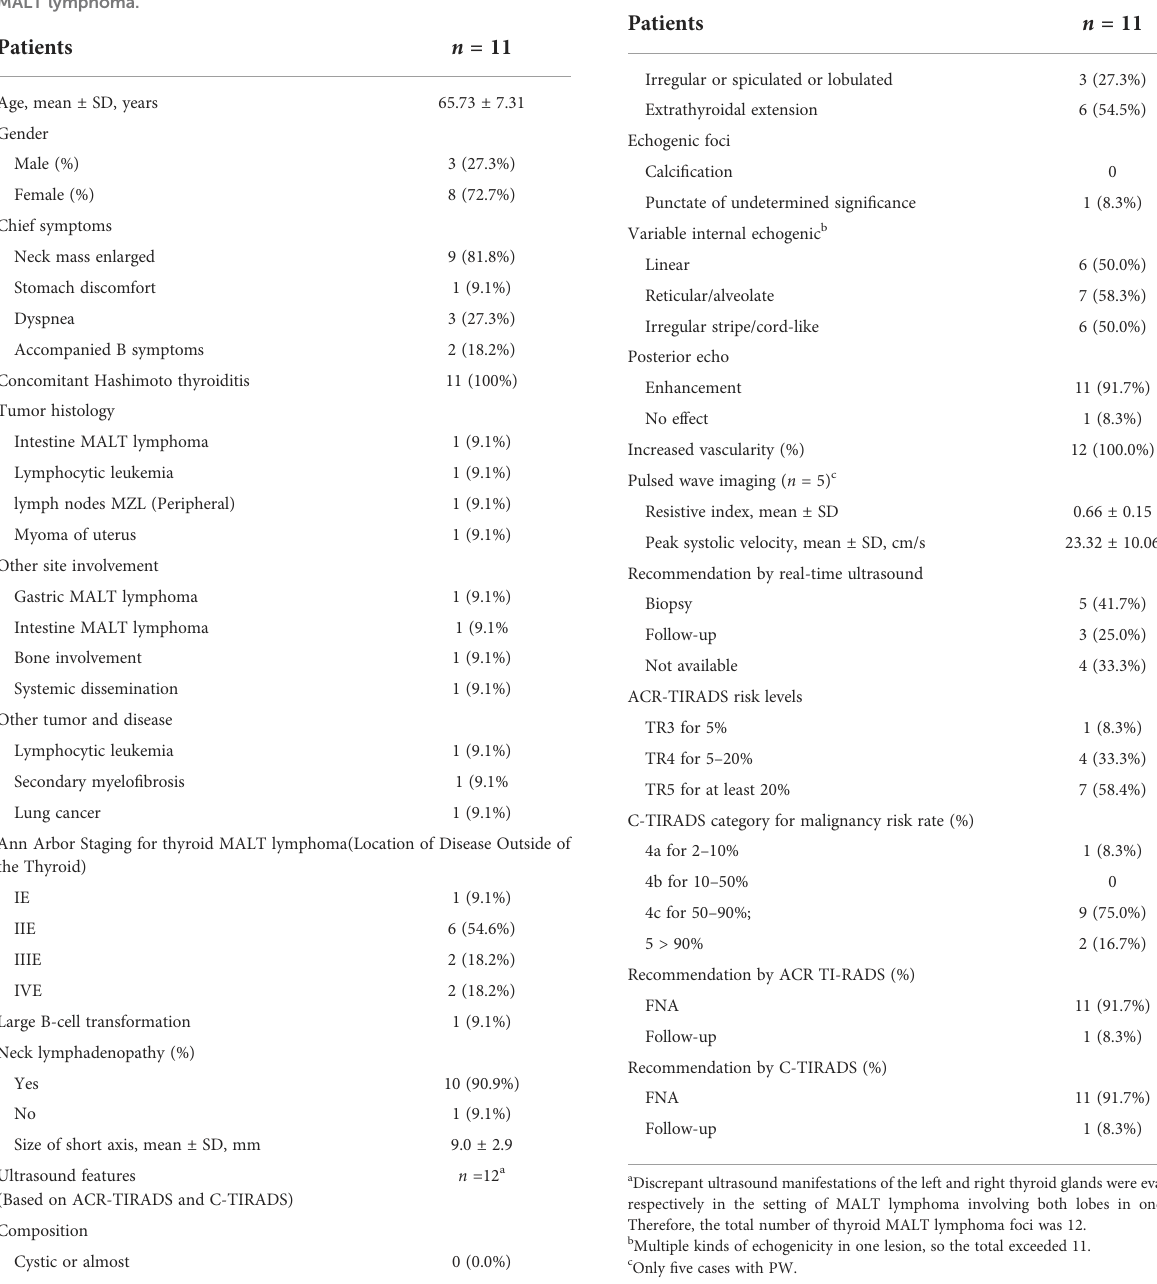
TABLE 2 Demographic, clinical, and ultrasound features of thyroid MALT